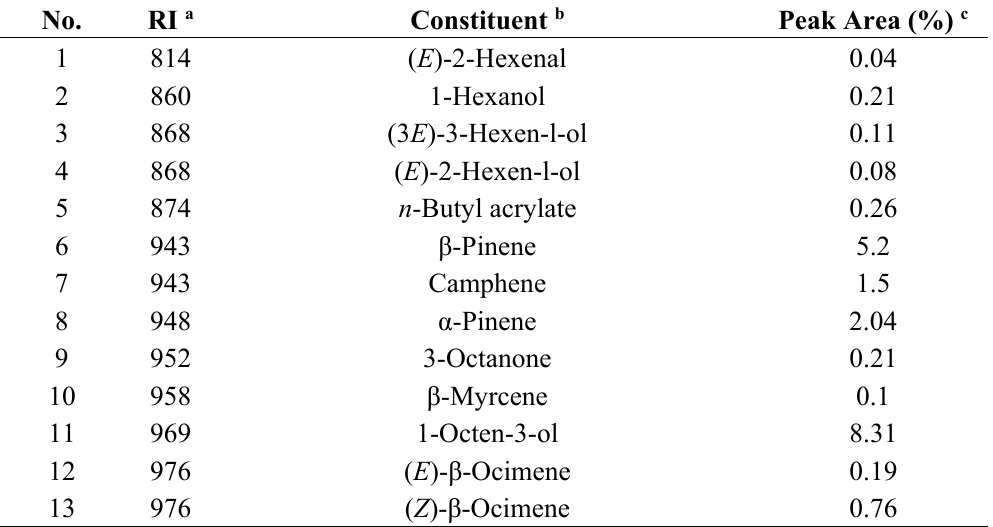
Table 1. Chemical constituents of volatile oil from Blumea balsamifera (BB